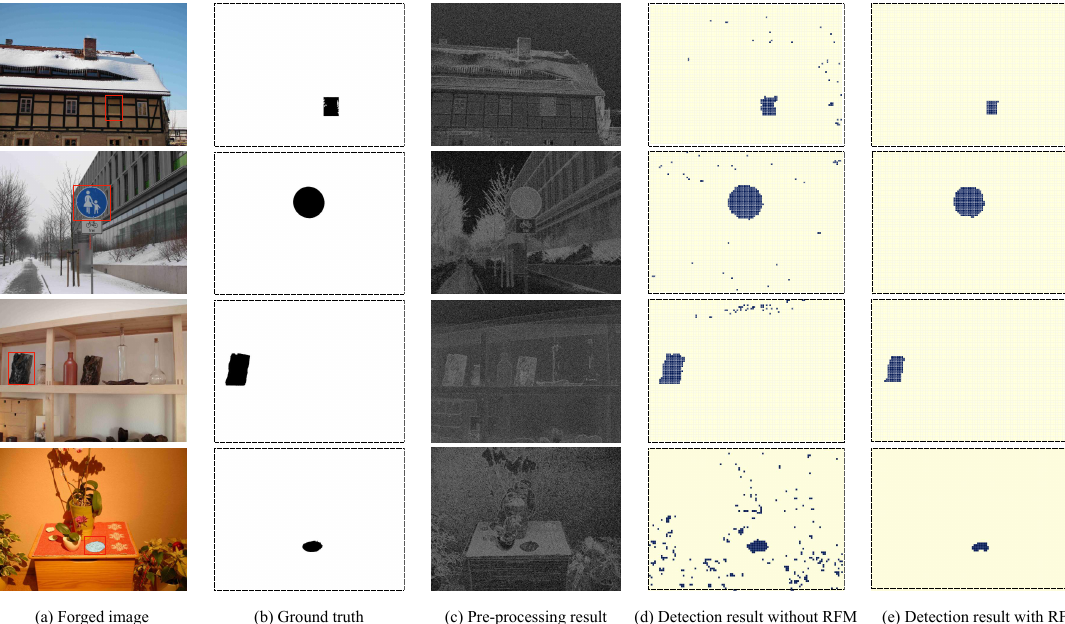
Figure 10. Tampering localization using our proposed RFM-based detector; from left to right: ( a ) forged image, ( b ) ground truth, ( c ) pre-processing result, ( d ) detection result without RFM (only relying on feature extraction), and ( e ) detection result with RFM (by adopting post-processing